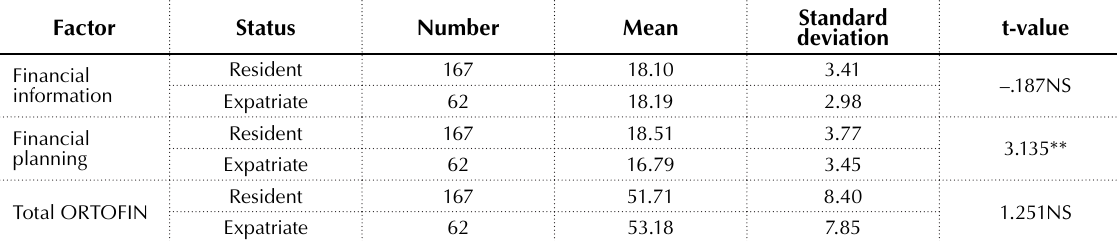
Table 2. Data and t-value of residents and expatriates